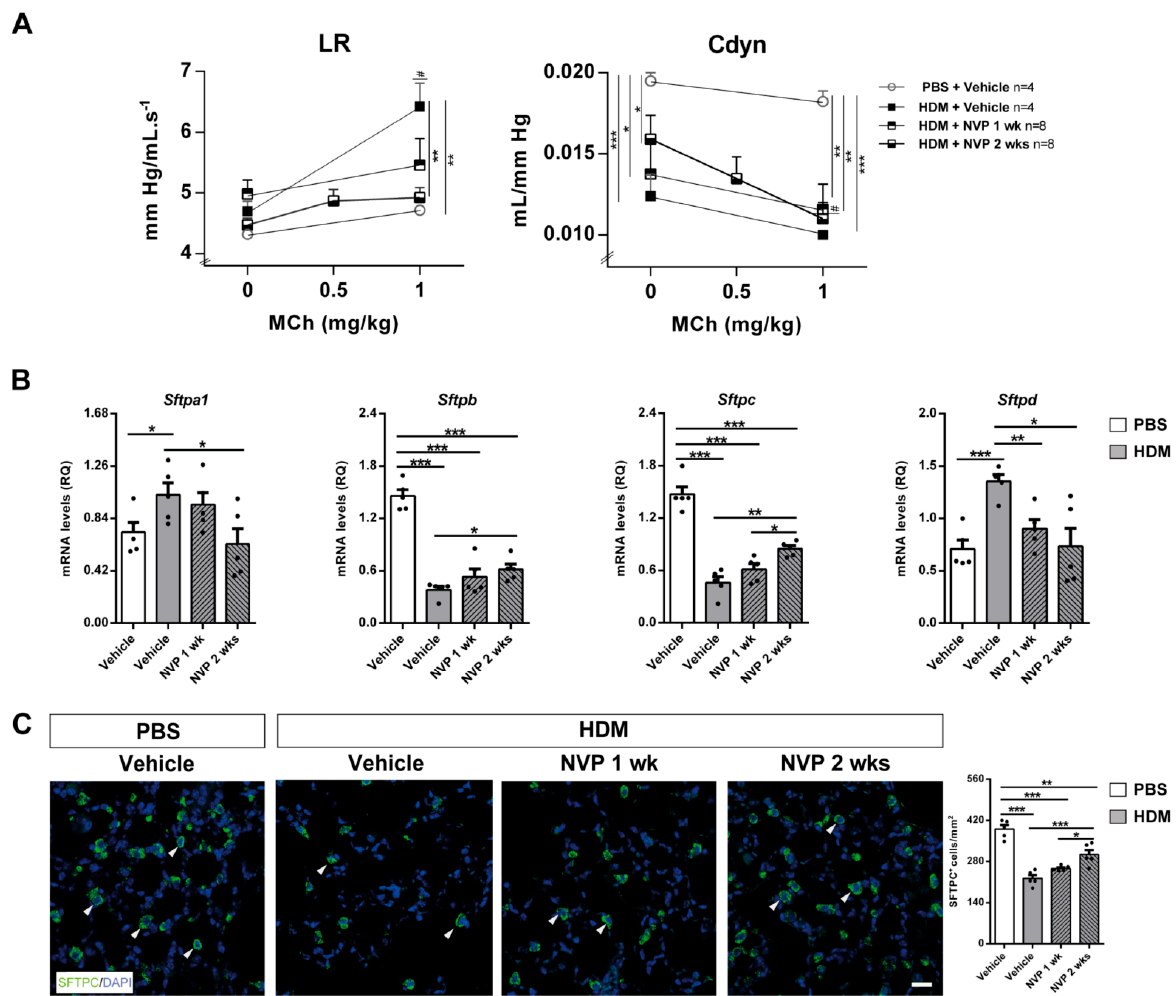
Figure 4. Therapeutic inhibition of IGF1R attenuates AHR and normalizes pulmonary surfactant expression upon HDM-induced allergy. ( A ) Quantification of lung resistance (LR) and dynamic compliance (Cdyn) to methacholine (MCh) evaluated by plethysmography ( n = 4–8 mice per group) and ( B ) changes in lung tissue mRNA expression surfactant ( Sftp ) markers Sftpa1 , b , c , and d , normalized to 18S expression in HDM-challenged mice treated with NVP vs. controls ( n = 5 mice per group). ( C ) Representative immunostains for SFTPC (green) (white arrowheads), and quantification of the number of SFTPC + cells per unit area (mm 2 ) in lung sections from HDM-challenged mice treated with NVP vs. controls ( n = 5–10 mice per group; scale bar: 50 µm). Data are expressed as mean ± SEM. * p < 0.05; ** p < 0.01; *** p < 0.001; # p < 0.05 (comparisons within the same group) (Mann–Whitney U test or Student’s t -test for comparing two groups and Kruskal–Wallis test or ANOVA multiple comparison test for grouped or multivariate analysis).